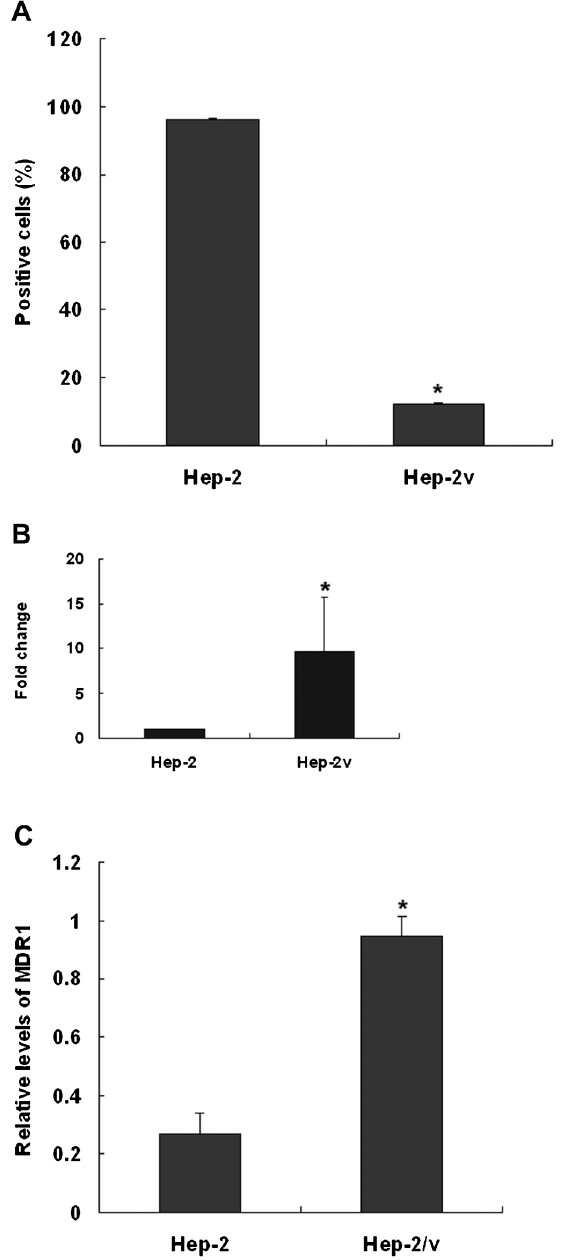
Figure 2. Rhodamine 123 efflux is increased and multidrug resistance 1 (MDR1) expression is up-regulated in Hep-2/v cells compared to Hep-2 cells. A , Rhodamine 123 retention in Hep-2 and Hep-2/v cells. The cells were incubated with rhodamine 123 and measured by flow cytometry. Data are reported as mean±SD percentages of rhodamine 123-positive cells. *P , 0.01 vs Hep-2 cells (chi-square test). B , Expression of MDR1 mRNA in Hep-2 and Hep-2/v cells. The relative levels of MDR1 mRNA in Hep-2 and Hep-2/v cells were determined by real-time reverse transcription-polymerase chain reaction. Data are reported as means±SD. *P , 0.01 vs Hep-2 cells (Student t - test). C , Expression of the MDR1 protein in Hep-2 and Hep-2/v cells. The relative levels of the MDR1 protein in Hep-2 and Hep-2/ v cells were determined by Western blotting. Data are reported as